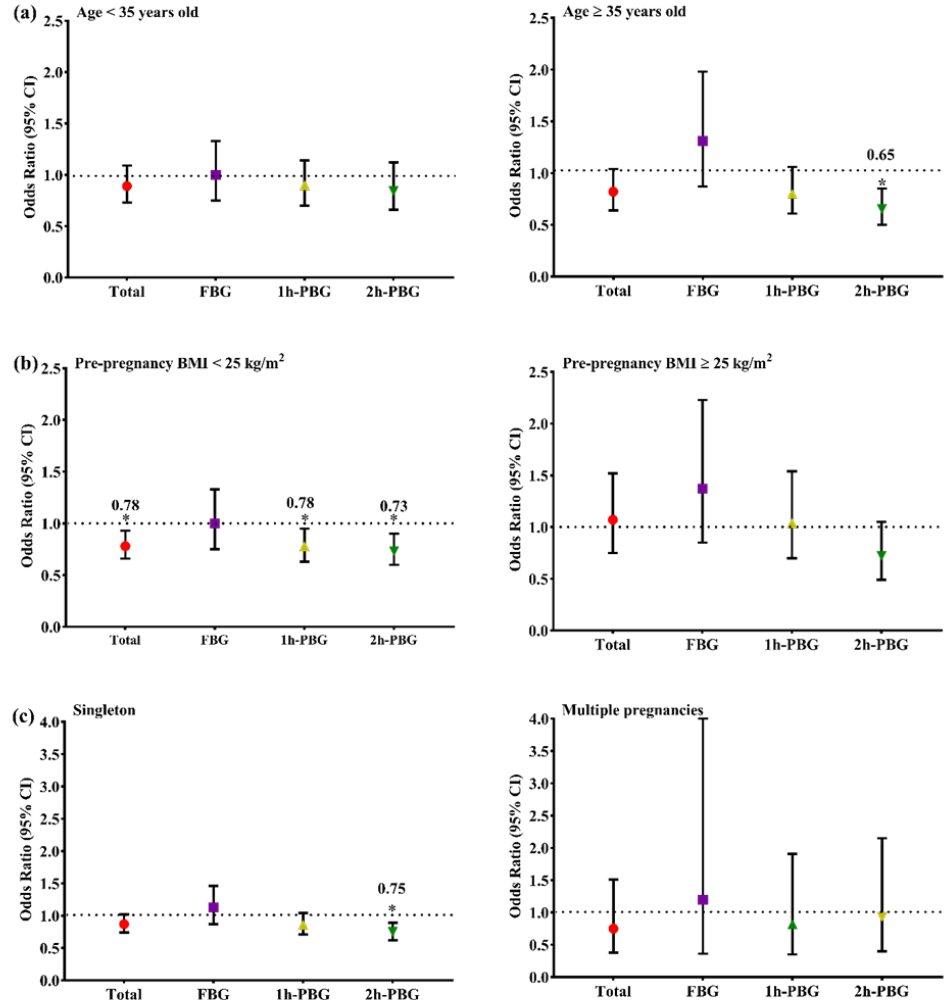
Figure 2. ORs and 95% CIs for GDM associated with folic acid supplementation in subgroups, stratified by age ( a ), pre-pregnancy BMI ( b ), number of pregnancies ( c ). All groups were adjusted for age, pre-pregnancy BMI, gravidity, parity, smoking history, drinking history, number of pregnancies, and macrosomia history. * p < 0.05.